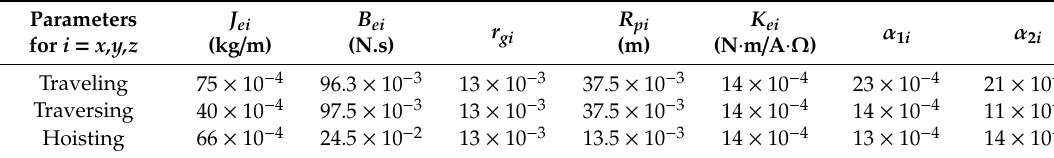
Table 1. Experimental Overhead Crane Setup Parameters.